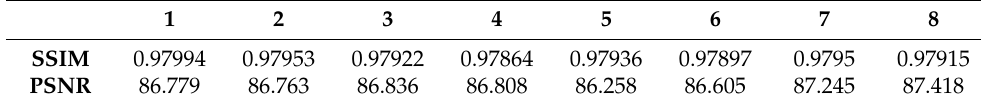
Table 3. SSIM and PSNR of the eight ANN structures of PWP-in.